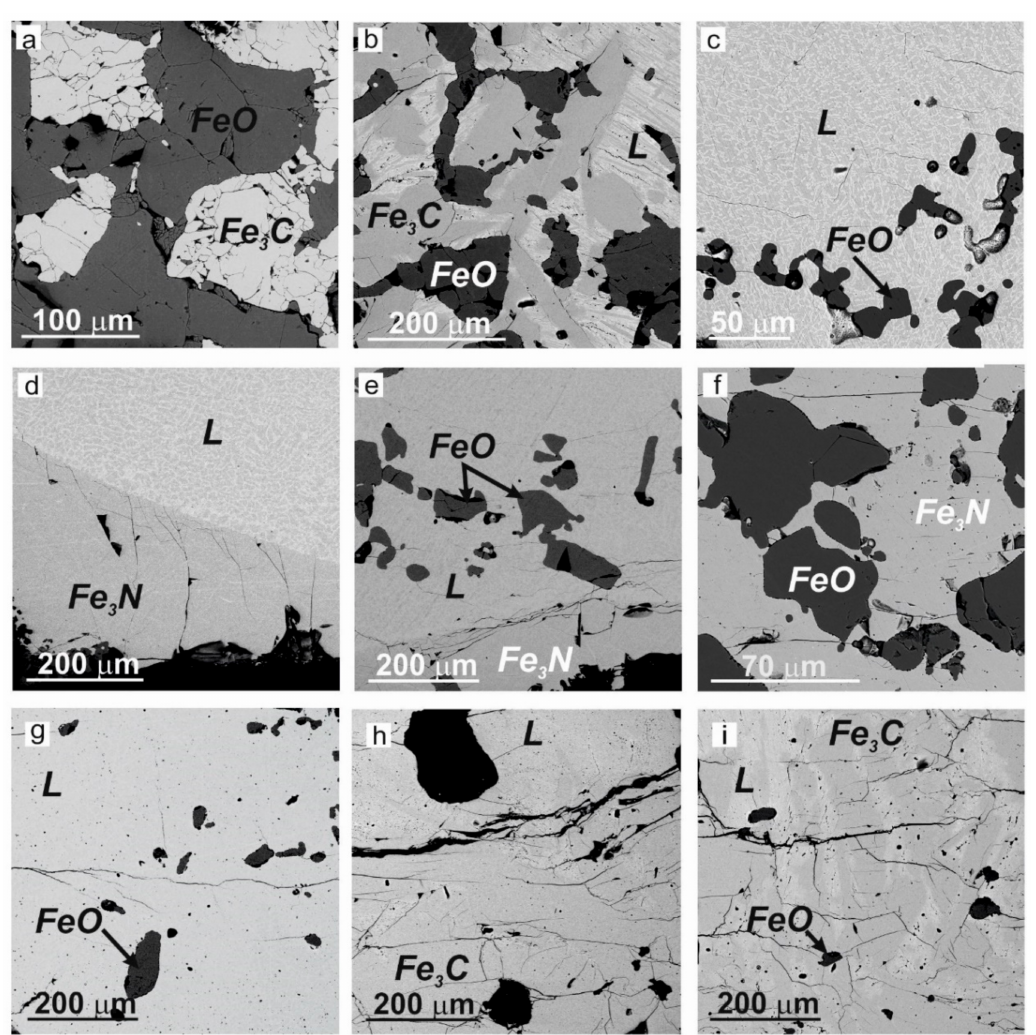
Figure 2. Photomicrographs of samples after experiments. ( a ): cohenite (Fe 3 C) and wüstite, sample